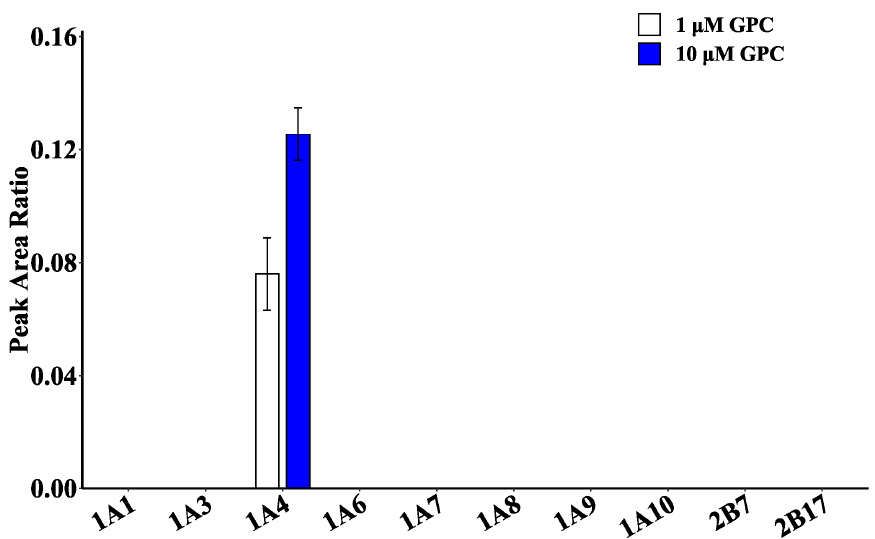
Figure 5. Activity assay of different recombinant human UGT enzymes (0.1 mg/mL) catalyzing glucuronidation metabolism of GPC (1, 10 μ M).